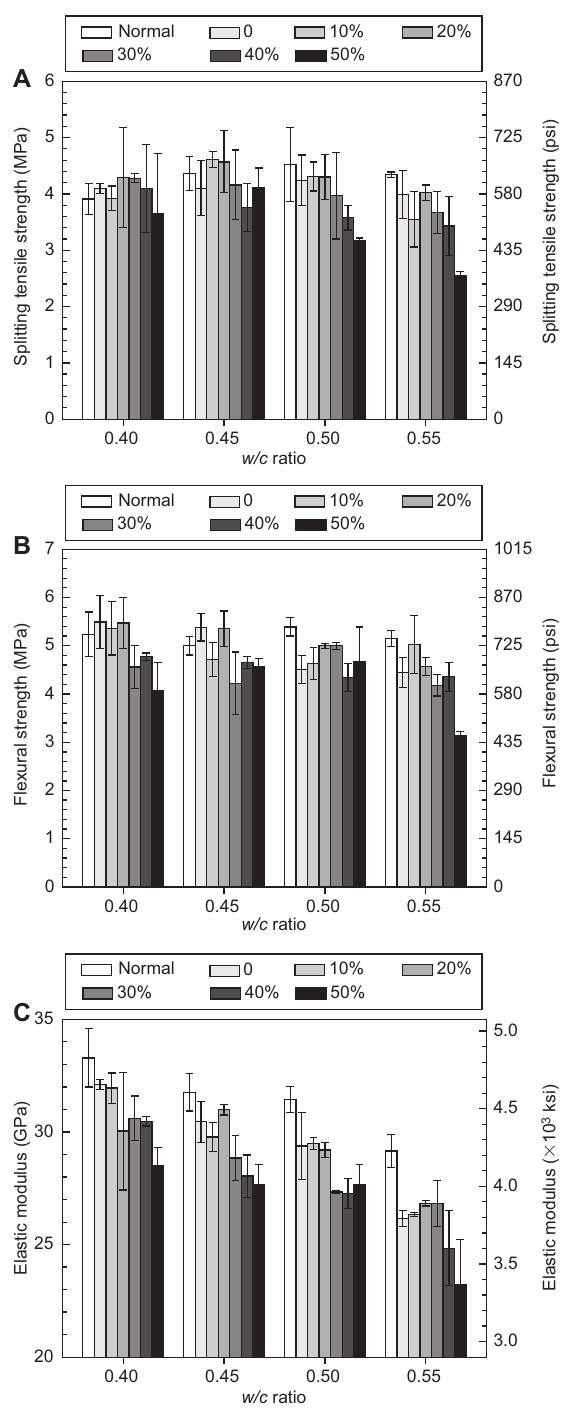
Figure 5 (A) Splitting tensile strength, (B) fl exural strength, and (C) elastic modulus of “ sandless ” concrete.